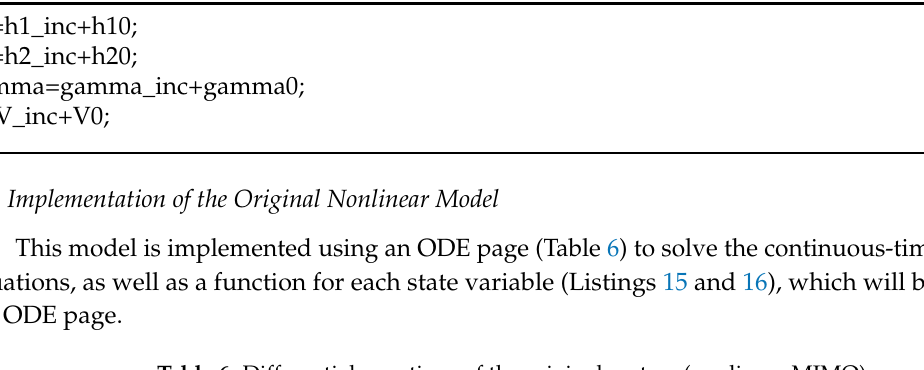
Table 6. Differential equations of the original system (nonlinear